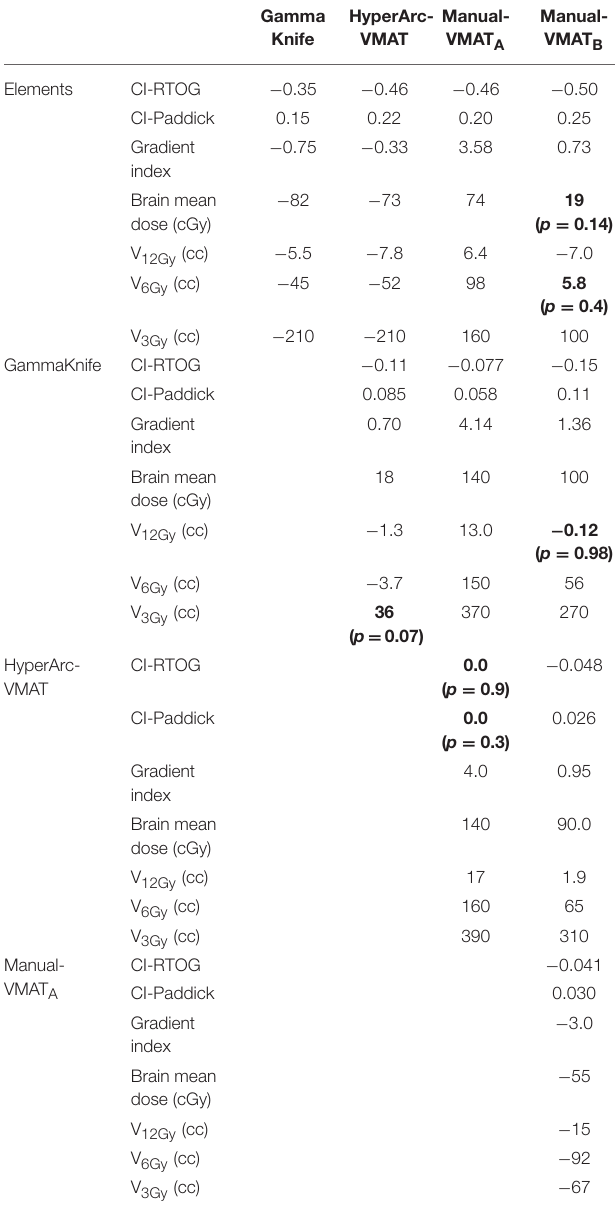
TABLE 2 | Median differences and Wilcoxon signed rank statistics for matched pair plan comparisons for conformity indices, gradient index, mean brain dose, and volume of the brain receiving 12Gy, 6Gy, and 3Gy.